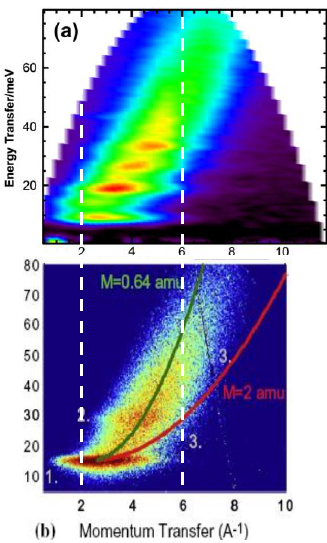
Figure 5. Experimental intensity maps S ( K , E ) of the two original results of [25] ( a ) and [24] ( b ), appropriately stretched/scaled to facilitate visual comparison. The two vertical dashed lines (white) are guides to the eye. The two broad continuous features caused by the roto-translational modes are virtually identically distributed in the K − E plane, and they clearly lie in the quantum regime, i.e., on the “left” of the H-recoil parabola of H. (Figure taken from Ref.